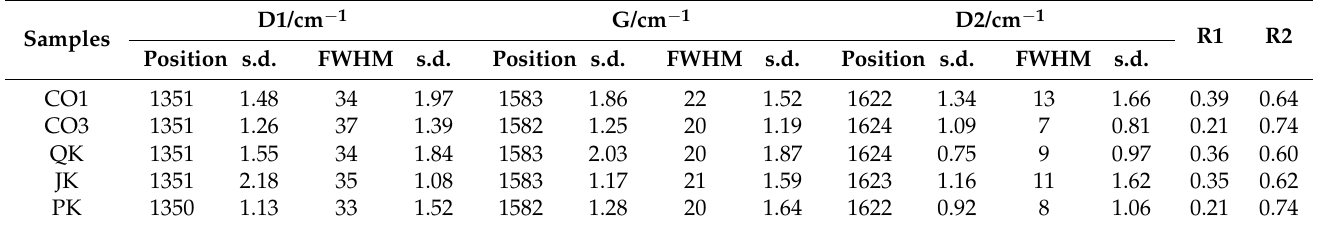
Figure 6. ( a ) Raman spectra of graphite microcrystals in graphitized coal; ( b ) peak fitting of Raman spectrum in the first-order region of sample CO1; ( c ) peak fitting of Raman spectrum in the second- order region of sample CO1. Table 2. First-order Raman spectral parameters of graphite microcrystals derived from peak fit- ting.